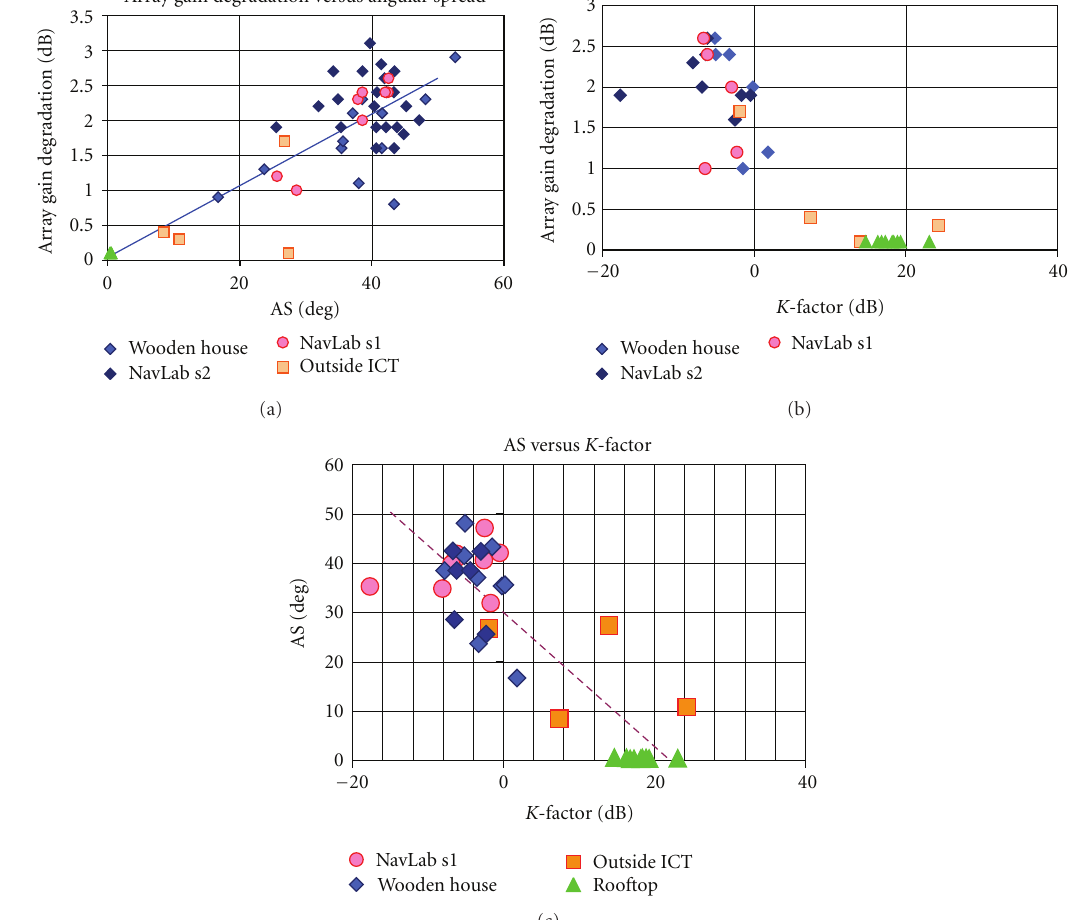
gain. To illustrate this connection between the CC and array gain, the spatial CC of select PRNs is shown in Figure 12.